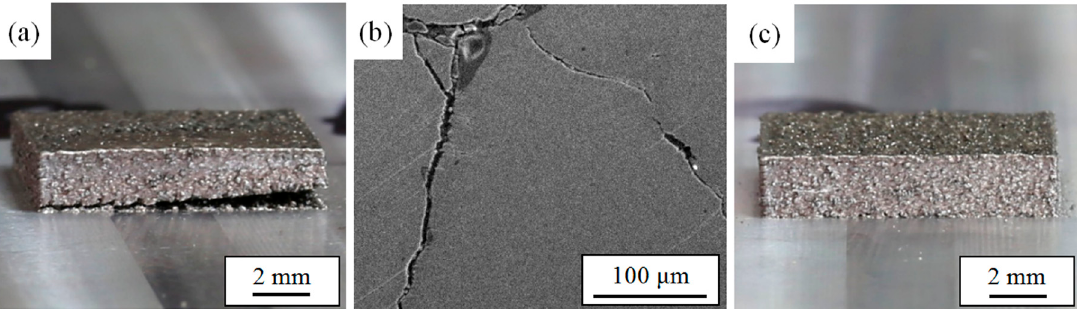
Figure 10. Experimental SLM-forming samples. ( a ) Warping deformations in the sample; ( b ) Cracks in the sample; ( c ) A high-quality sample.